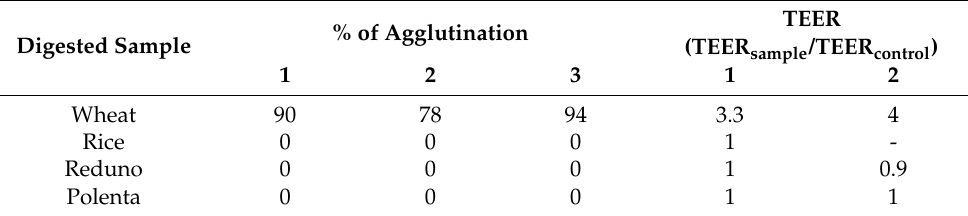
Table 1. Measurement of % of agglutinated K562(S) cells and transepithelial electrical resistance (TEER, ∆Ω ms/mm 2 ) incubated with the digested products from cereals. TEER % of Agglutination Digested Sample (TEER sample /TEER control ) 1 2 3 1 2 Wheat 90 78 94